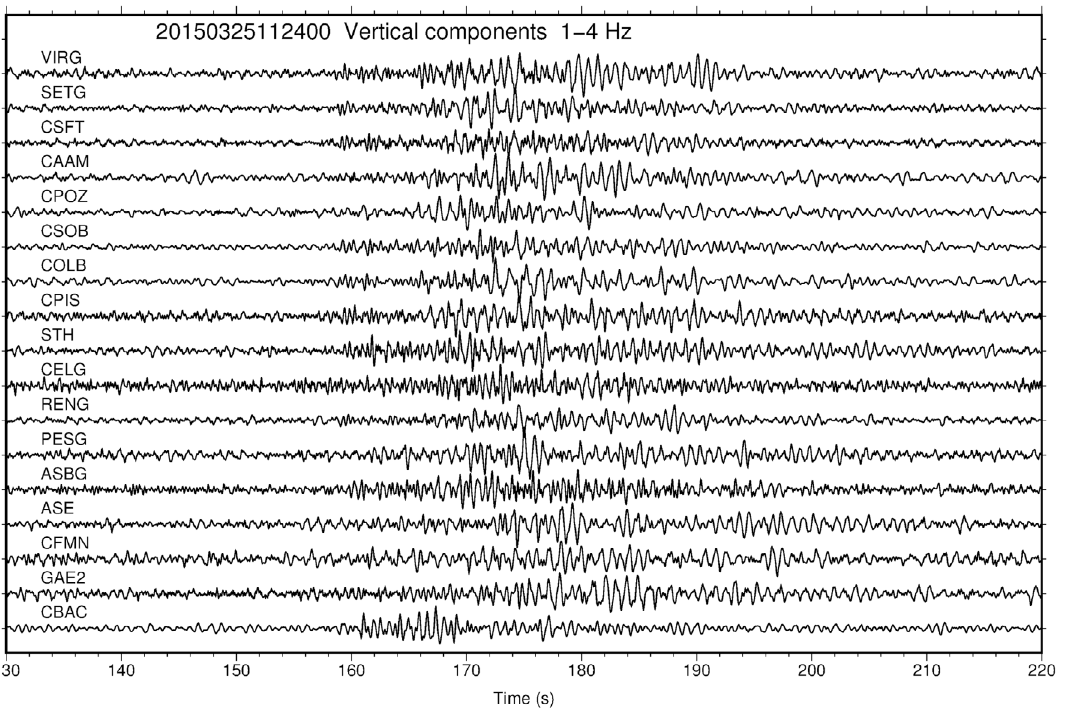
Figure 10. Low Frequency earthquake recorded in Campi Flegrei caldera on March 25, 2015. Signals are bandpass filtered between 1 Hz and 4 Hz and roughly ordered with epicentral distance increasing from top to